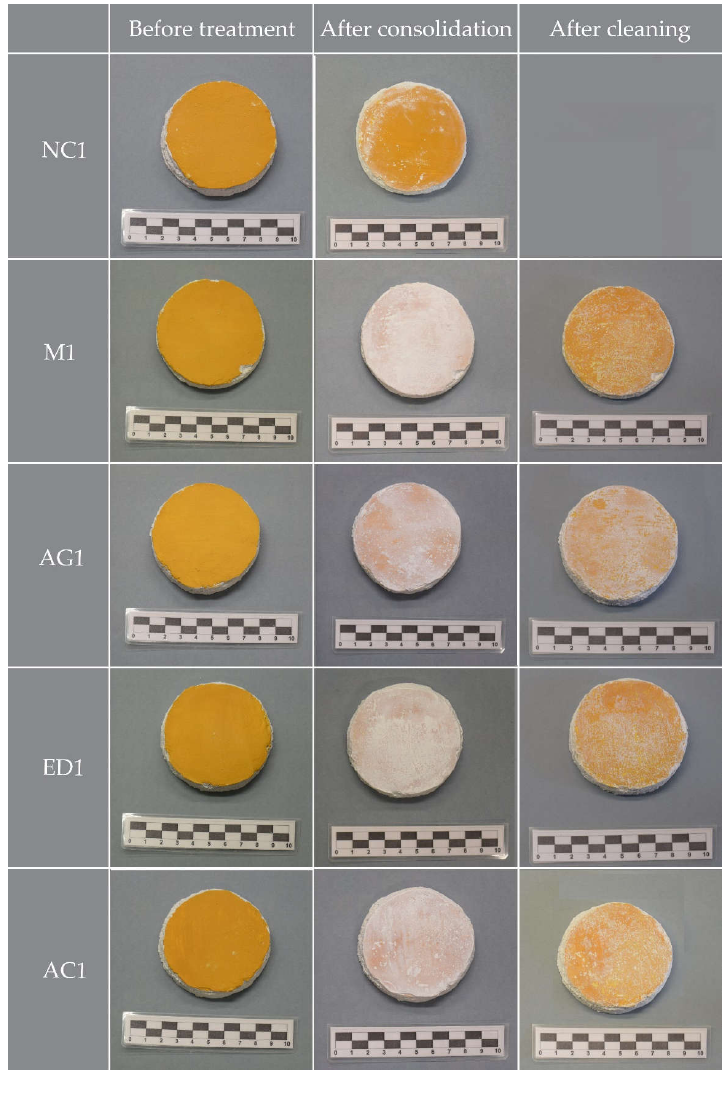
Figure 3. Photographic record of the specimens before the treatment, after the consolidation and after the cleaning. Due to the similarities between samples, only one sample per testing condition is included.